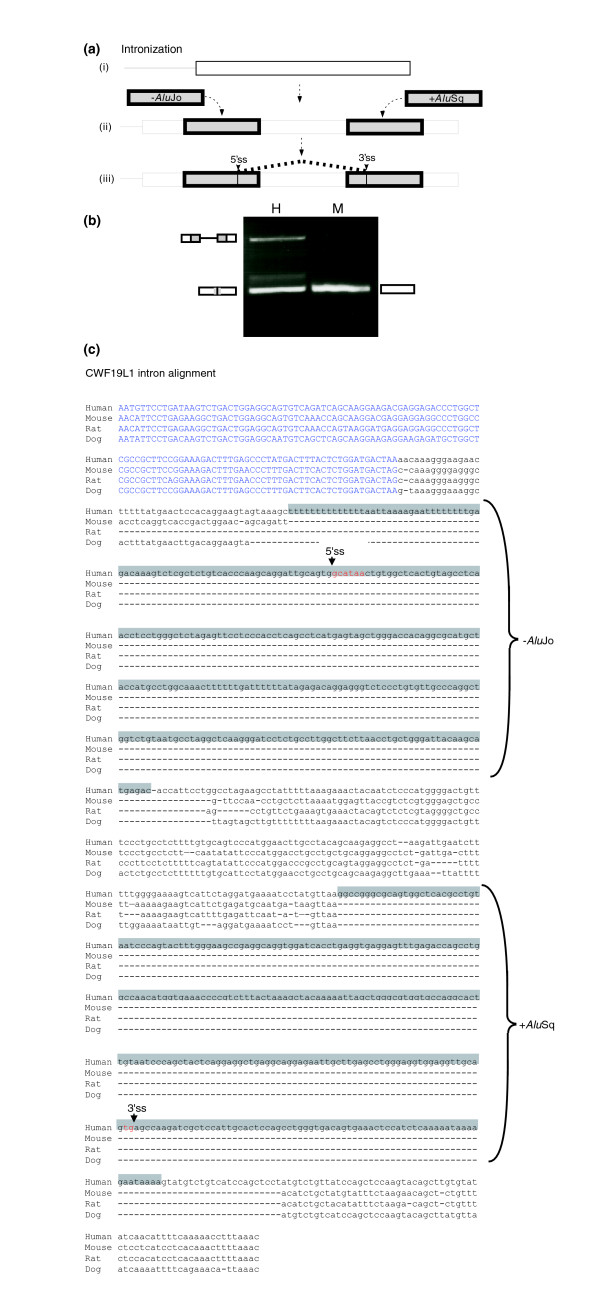
Alu insertions into an exon activate intronization in the CWF19L1 gene. (a) Intronization. (i) Illustration of the last exon of the CWF19L1 gene in mouse. (ii) During primate evolution, two Alu elements were inserted into the exon. (iii) Because of these insertions, an intronization process activates two splice sites within the exon, a 3' and a 5' splice site. The isoform in which the intron is spliced out is supported by 12 mRNA/expressed sequence tags (ESTs), and the isoform in which the intron is retained is supported by four mRNA/ESTs. (b) Testing the splicing pathway of this exon between human and mouse. Polymerase chain reaction (PCR) analysis on normal cDNAs from human kidney (marked H) and from mouse brain tissue (marked M). PCR products were amplified using species-specific primers, and splicing products were separated in 1.5% agarose gel and sequenced. (c) Alignment of the sequence of the last exon of the CWF19L1 gene among human, mouse, rat, and dog is shown. The two Alu elements are marked in gray. The selected 5'ss and 3'ss are marked.